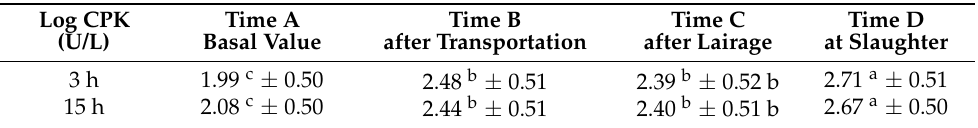
Table 1. CPK (log) values at different times, within each slaughter group. Least-square means ± Standard error. Log CPK Time A (U/L) Basal